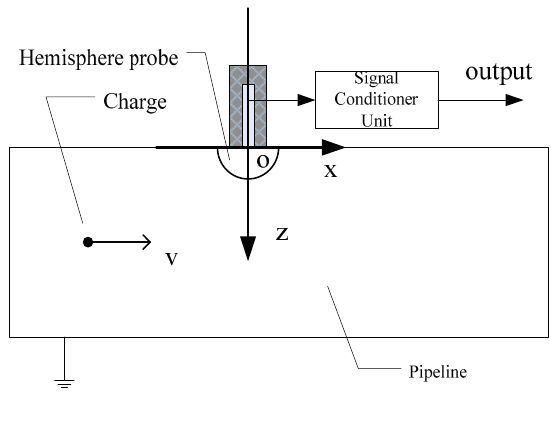
Figure 1. Schematic of the hemisphere-shaped sensor